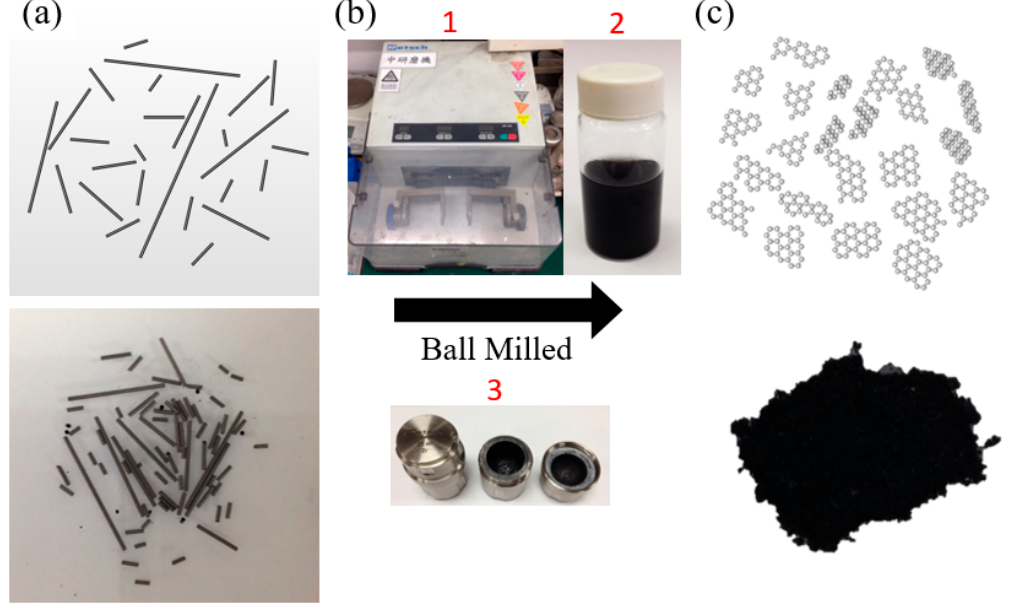
Figure 1. A schematic representation of ( a ) recycled 2B; ( b ) optical photo showing the